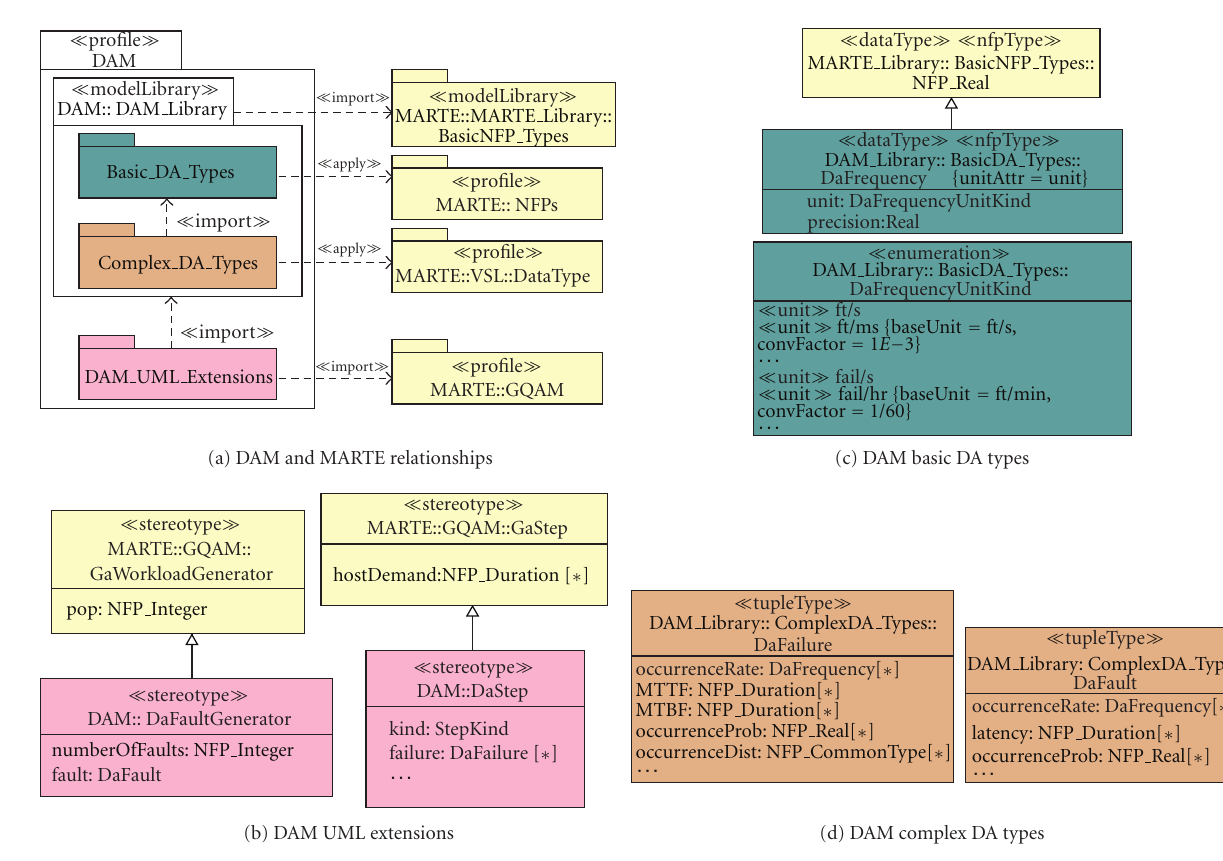
Figure 8: UML extensions for dependability